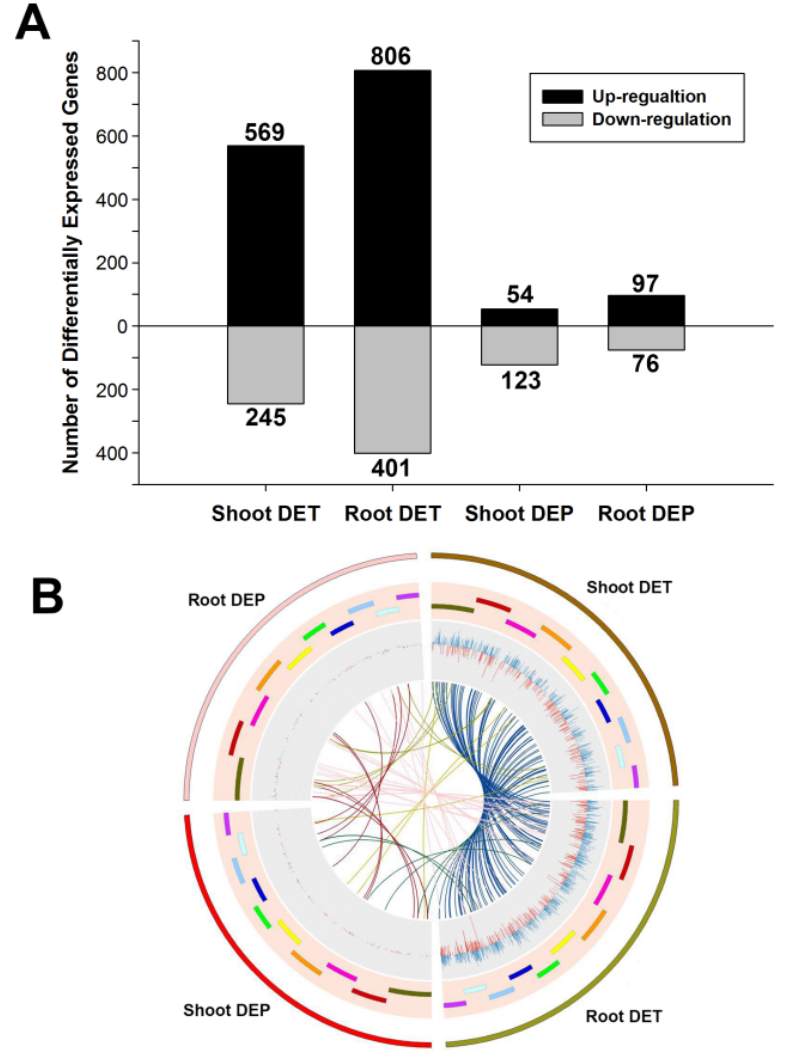
Figure 2. Identification of differentially expressed genes. ( A ) DETs and DEPs in roots and shoots. ( B ) Combination analysis of DET and DEP, from the outside to the inside, the outermost circle represents different differentially expressed genes. The penultimate circle represents the chromosome of maize. The third last round represents the fold change in gene expression. The lines in innermost represent genes showed differential expression at different tissues or different expression levels.